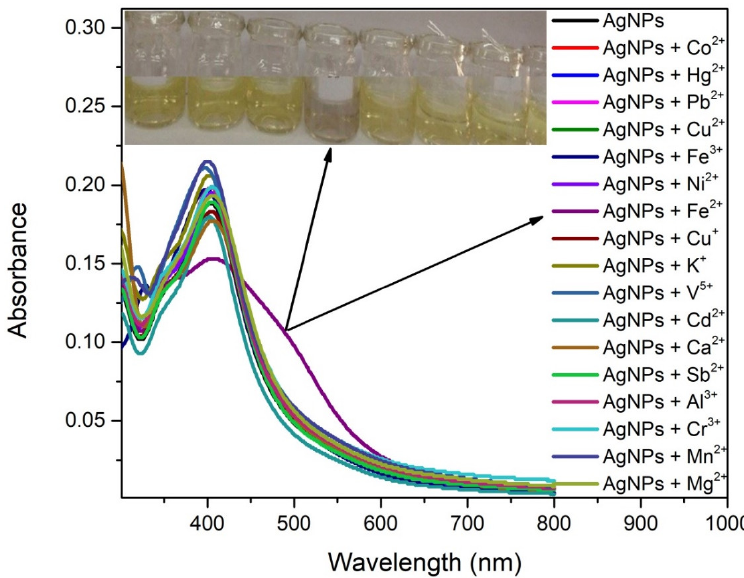
Figure 4. Individual metal ion effect on Ferene-S-conjugated silver nanoparticles.